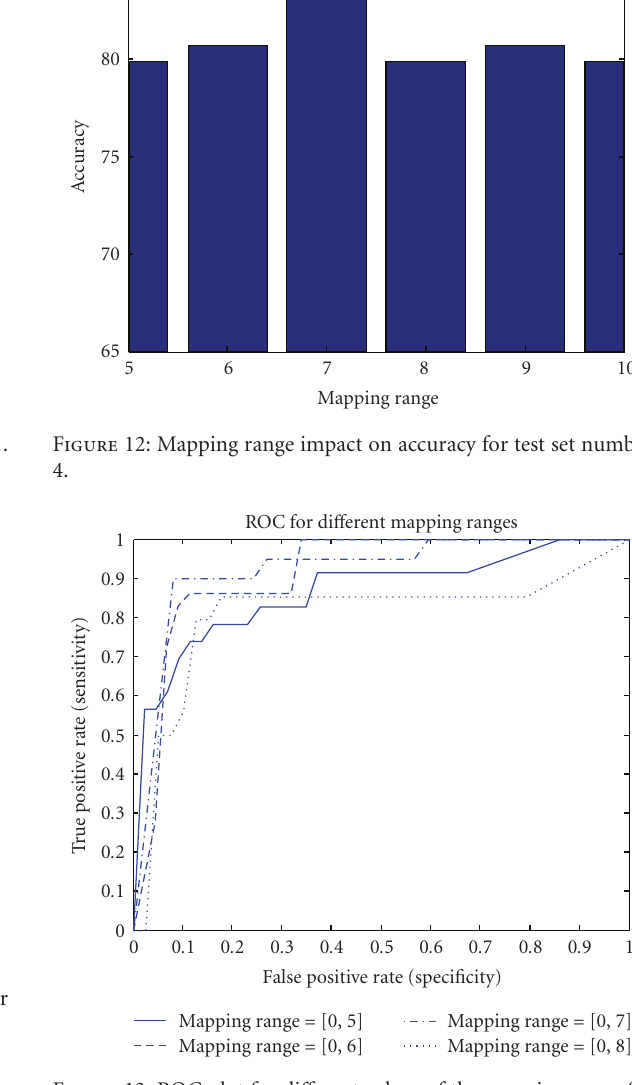
Figure 13: ROC plot for di ff erent values of the mapping range for testing set number